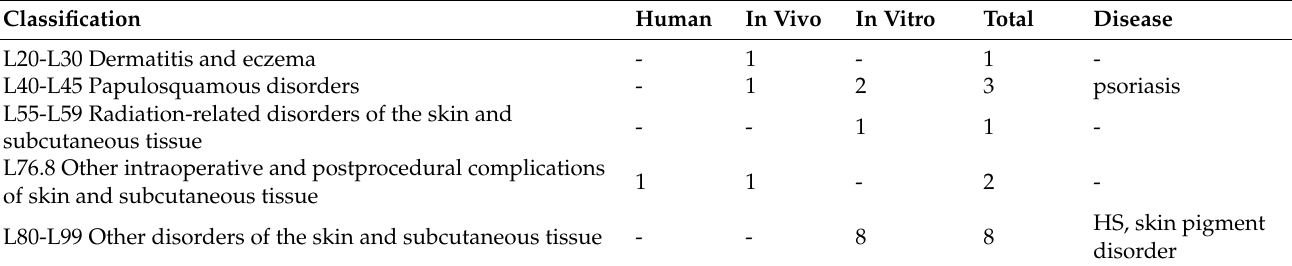
Table 14. The statistics of pharmacological results and its major diseases of SMC by experimental type in XII Diseases of the skin and subcutaneous tissue of